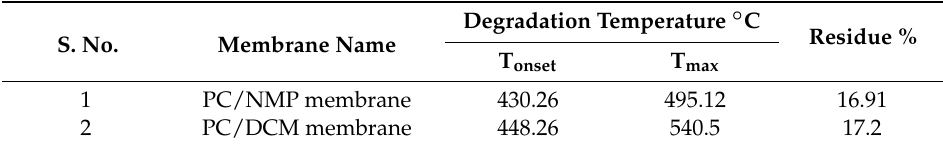
Table 3. Thermal properties of 18 wt % PC membranes prepared with different